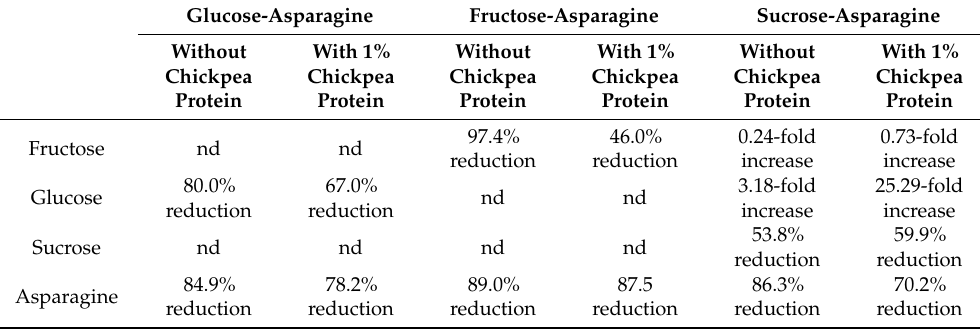
Table 2. Changes in the content of monosaccharides, sucrose, and the amino acid asparagine in model systems with and without the addition of a chickpea protein preparation, subjected to